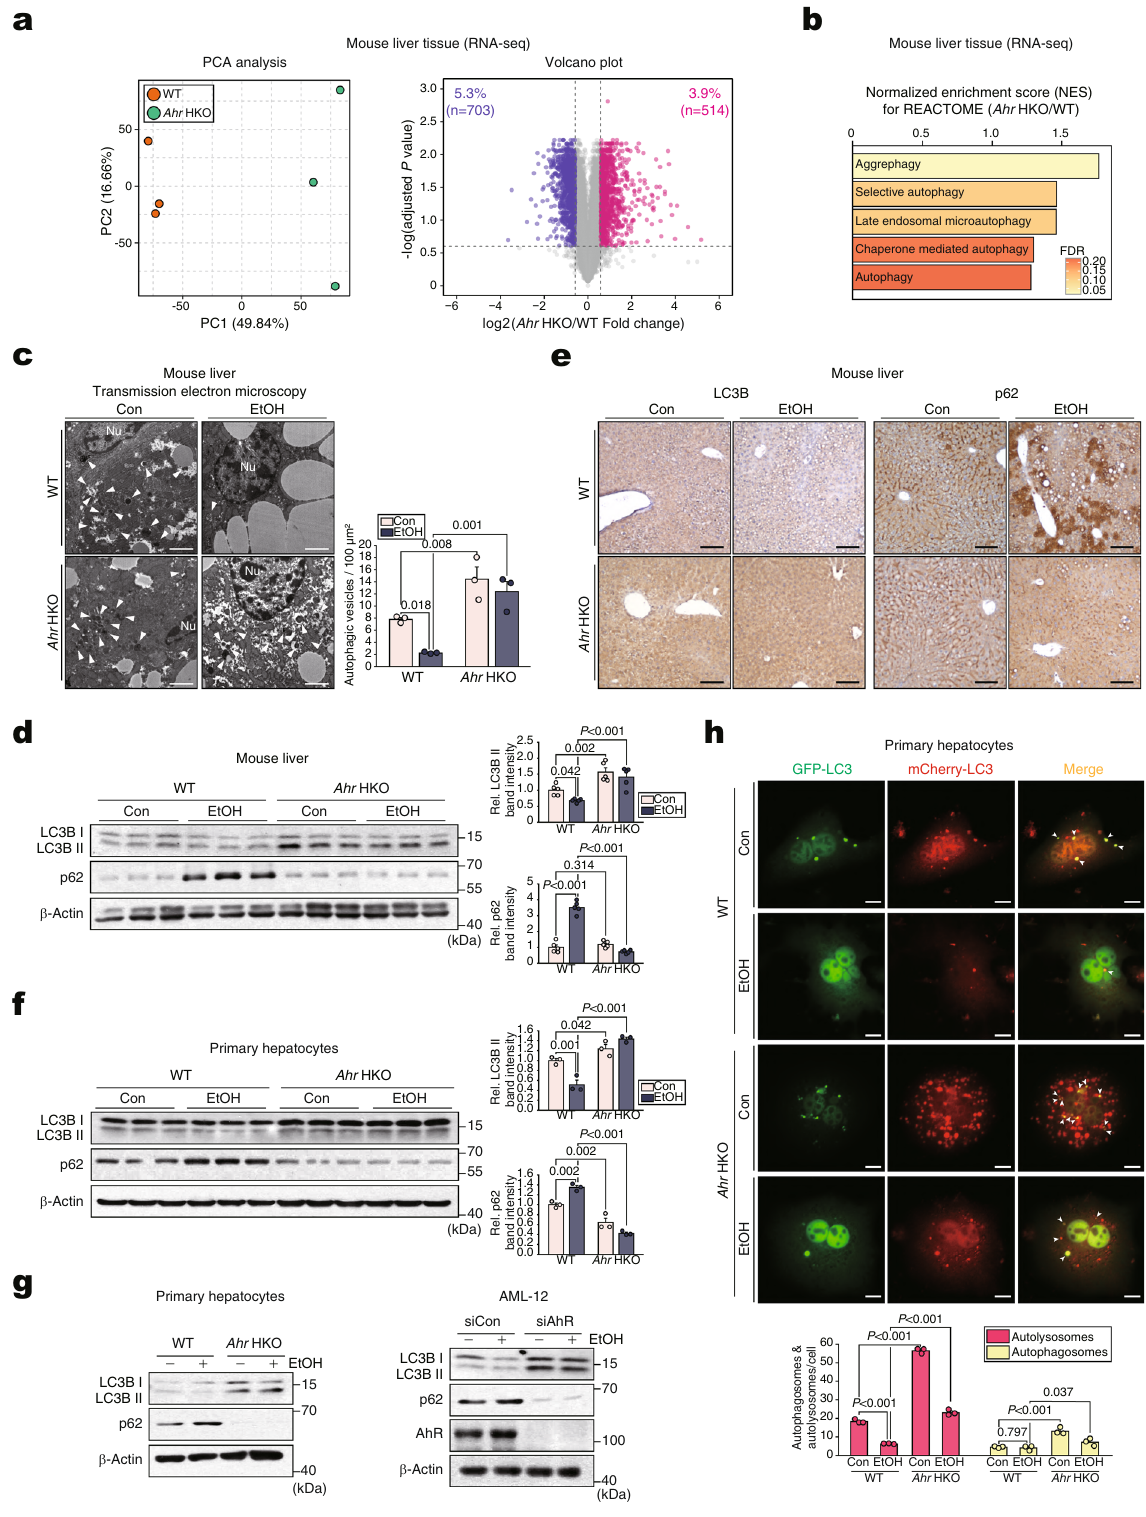
facilitated the induction of PPP2R2D in AML-12 cells (Fig. 5i). Similar outcomes were obtained using FICZ (Supplementary Fig. 5d). The key role of AhR in the induction of PPP2R2D by kynurenine was veri fi ed using AhR knockout and knockdown methods in cells (Fig. 5j). The JASPAR database was used to validate the transactivating effect of AhR on the target gene, and two putative AhR responsive